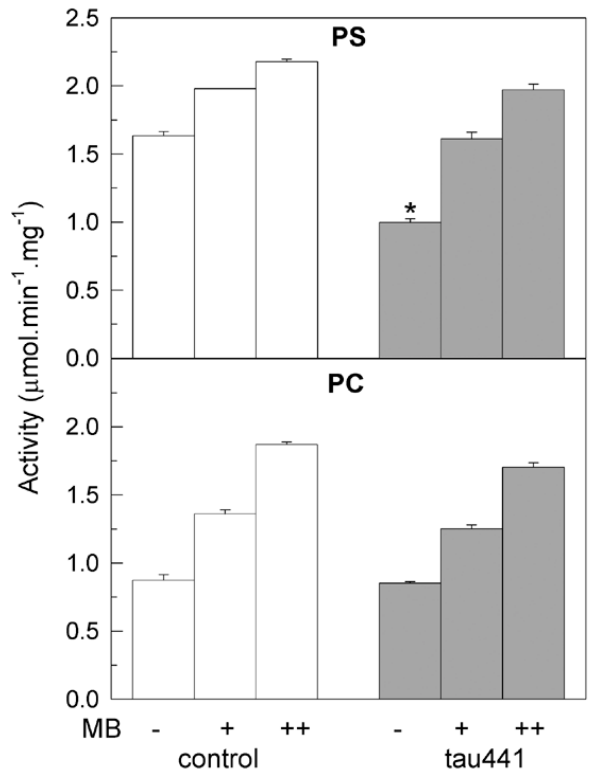
Figure 2. MB activates the purified synaptosomal plasma membrane Ca 2 + -ATPase (PMCA) activity and reverses the inhibitory e ff ect of tau, independently of the lipid used for reconstitution. Purified PMCA from pig brain (2.5 µ g) was mixed with 13.3 µ g of phosphatidylserine (PS) or phosphatidylcholine (PC), and incubated for 2 min at 37 ◦ C in the absence (white bars) or presence (grey bars) of 7.5 nM of tau in a 25 µ L total volume, followed by the addition of up to 1 mL assay medium. The Ca 2 + -ATPase activity was measured as described in the Methods section, triggering the reaction with 1 mM ATP in the absence ( − ) and after subsequent additions of 50 µ M MB ( + ) and 100 µ M MB ( ++ ). Activity values are expressed in µ mol.min − 1 .mg − 1 protein mean ± SE of eight experiments performed with four preparations. * p < 0.001 vs. control.